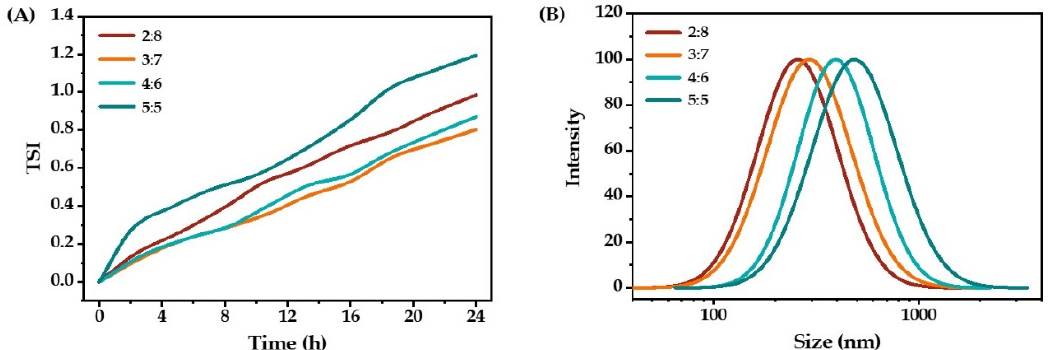
Figure 4. The stability ( A ) and droplet size distribution ( B ) of O/W emulsions prepared with different oil-to-water ratios.